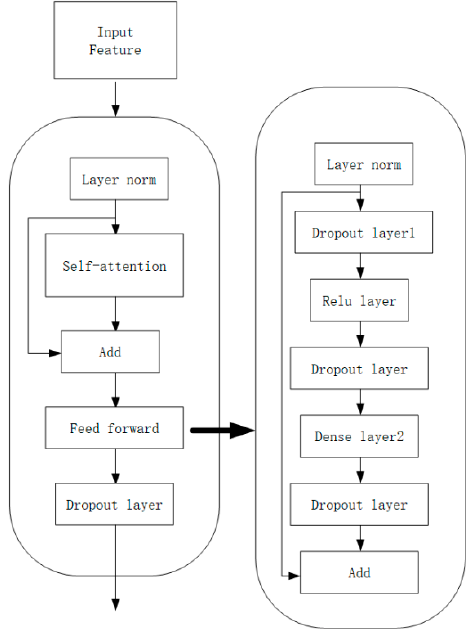
Figure 6. Transformer architecture.